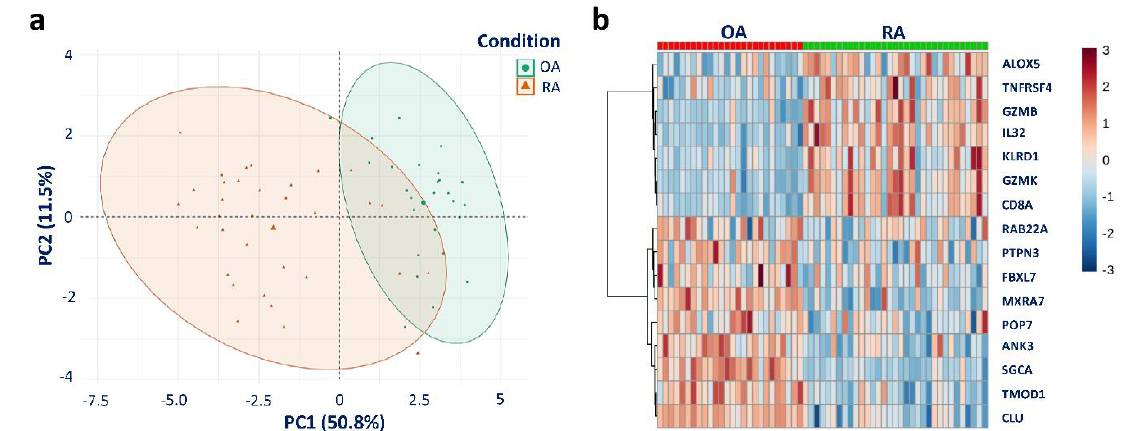
Figure 2. PCA and heatmap analysis of the data set with the 16-gene signature. ( a ) The sum of the two principal component is 62.3%. ( b ) Seven genes are upregulated, and nine genes are downregulated in RA compared to OA. PCA: Principal component analysis; RA: Rheumatoid arthritis; OA: